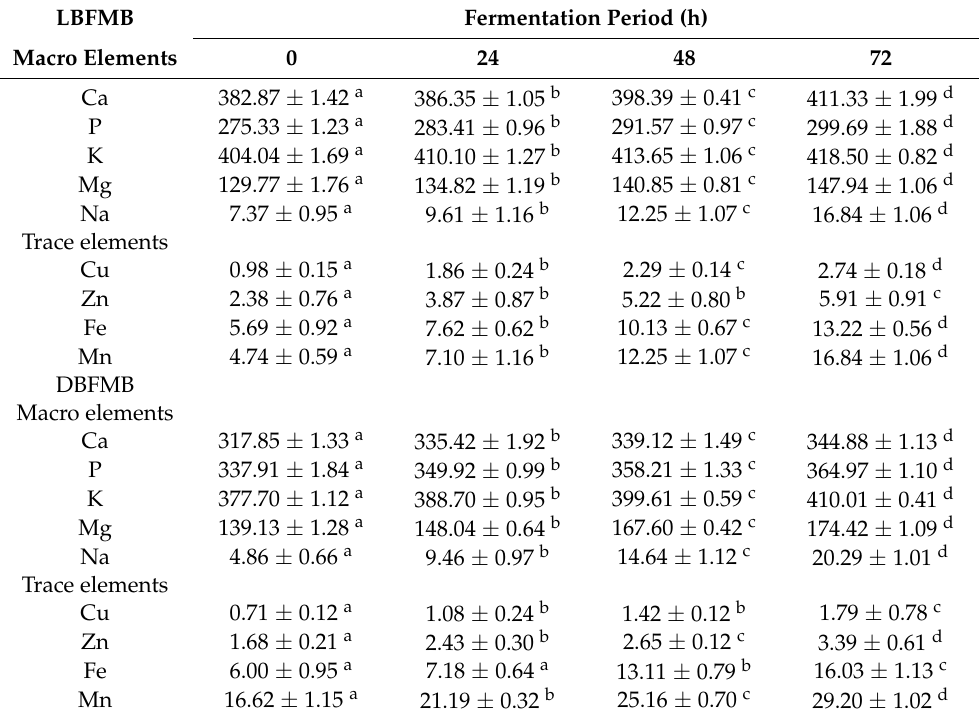
Table 2. Influence of spontaneous fermentation on macro and micro-minerals content of finger millet biscuits. (mg/100 g dry